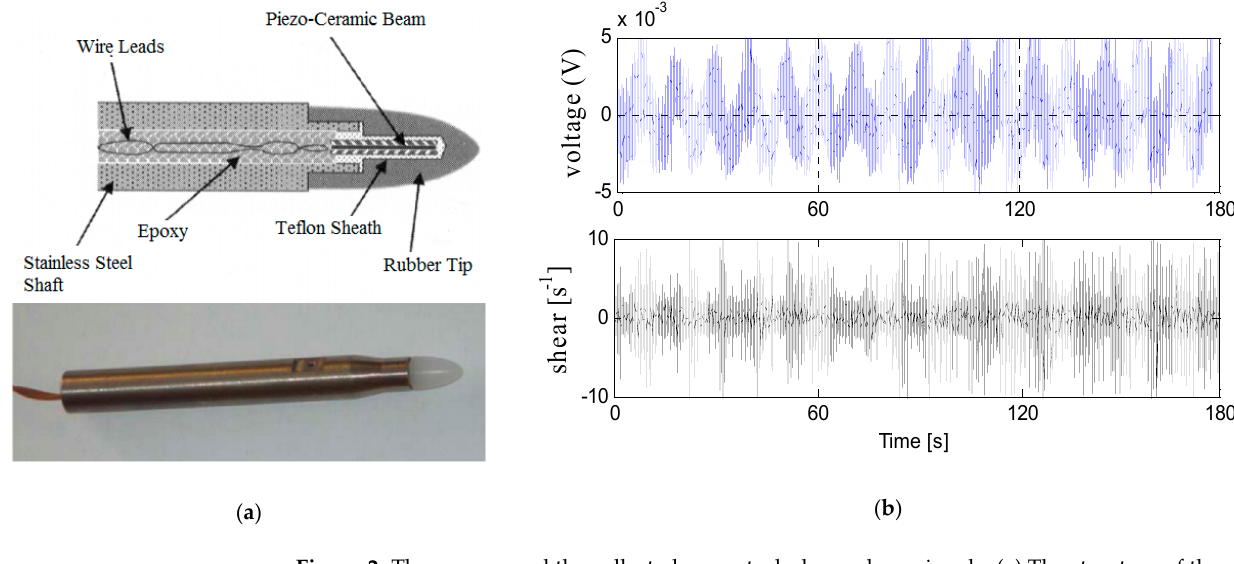
modes have different mean frequency and time